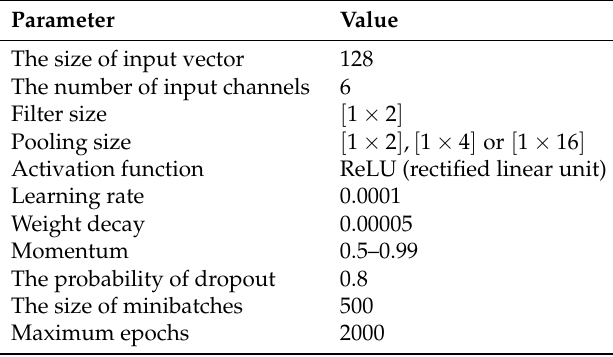
Table 2. Experiment